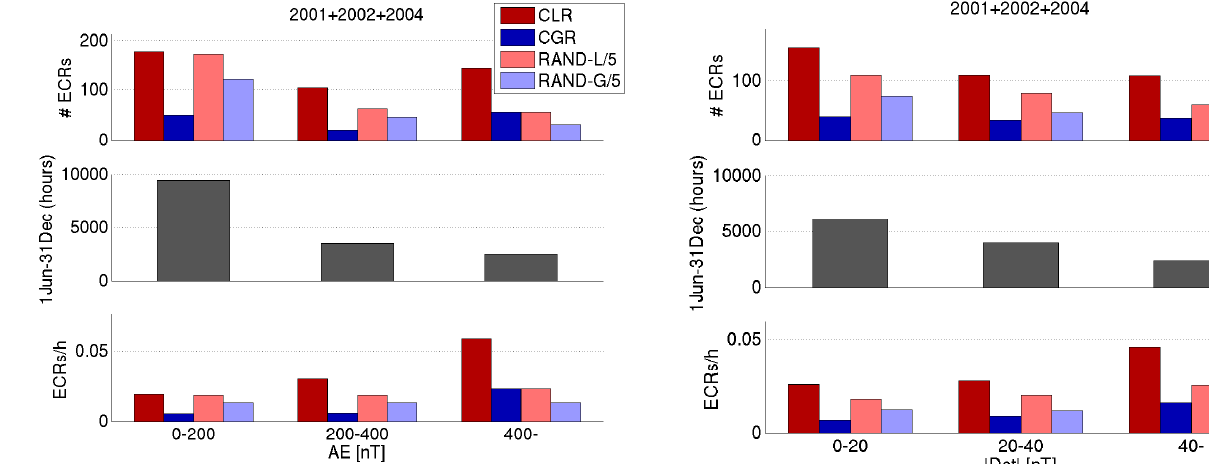
Fig. 4. Similar to Figs. 2 and 3, but here we instead investi- gate the importance of variations in the Dst index for the occur- rence of ECR and RAND events within the combined data base, 2001+2002+2004. Only data for negative Dst are included in the plot. The Dst bins are defined according to Dst < − 40nT, − 40nT ≤ Dst < − 20nT, and − 20 ≤ Dst < 0nT. However, note that the Dst axis is reversed so that smallest Dst, i.e., moderate to high geomagnetic activities, correspond to the rightmost bin.